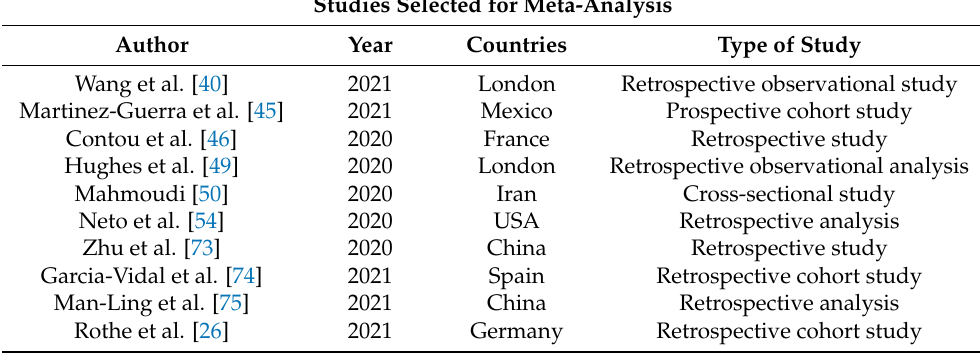
Table 1. Research selected for